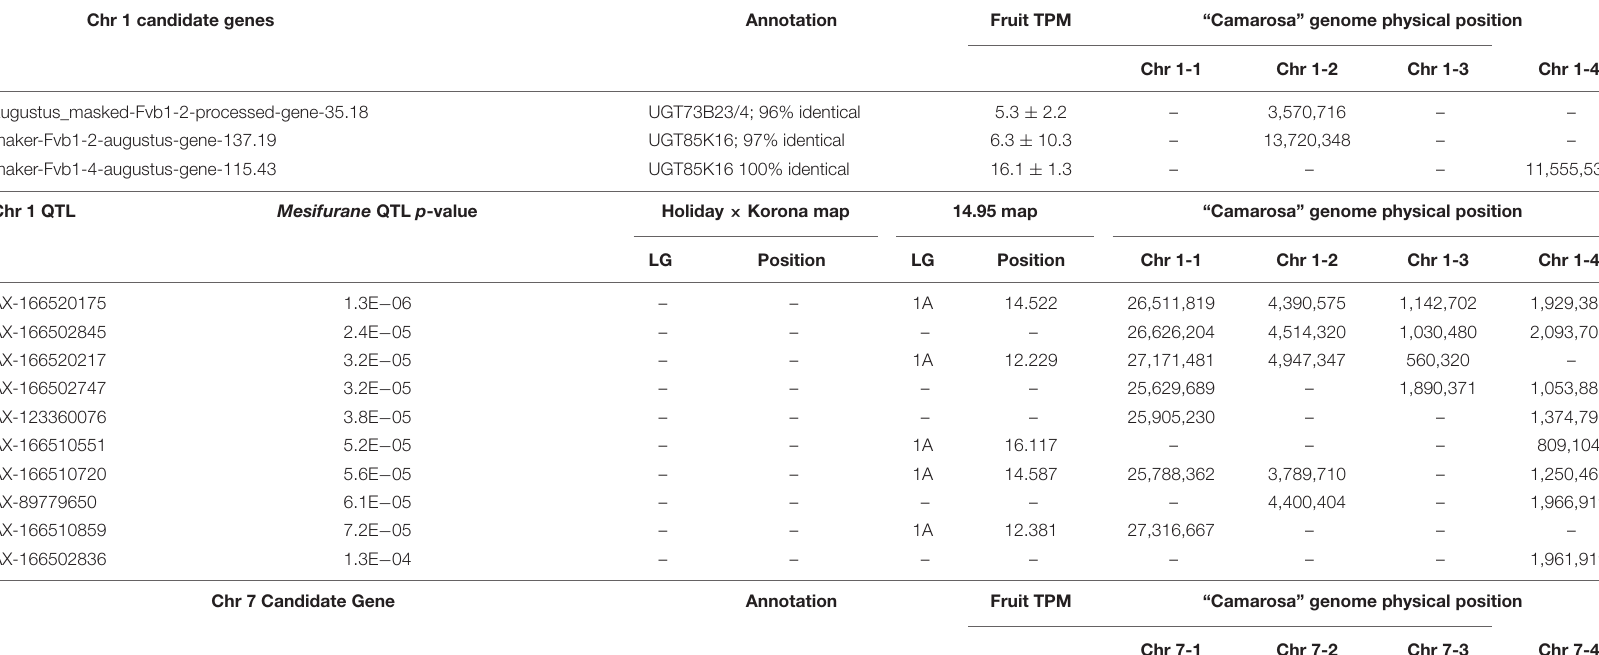
TABLE 2 | Mesifurane QTL and candidate gene